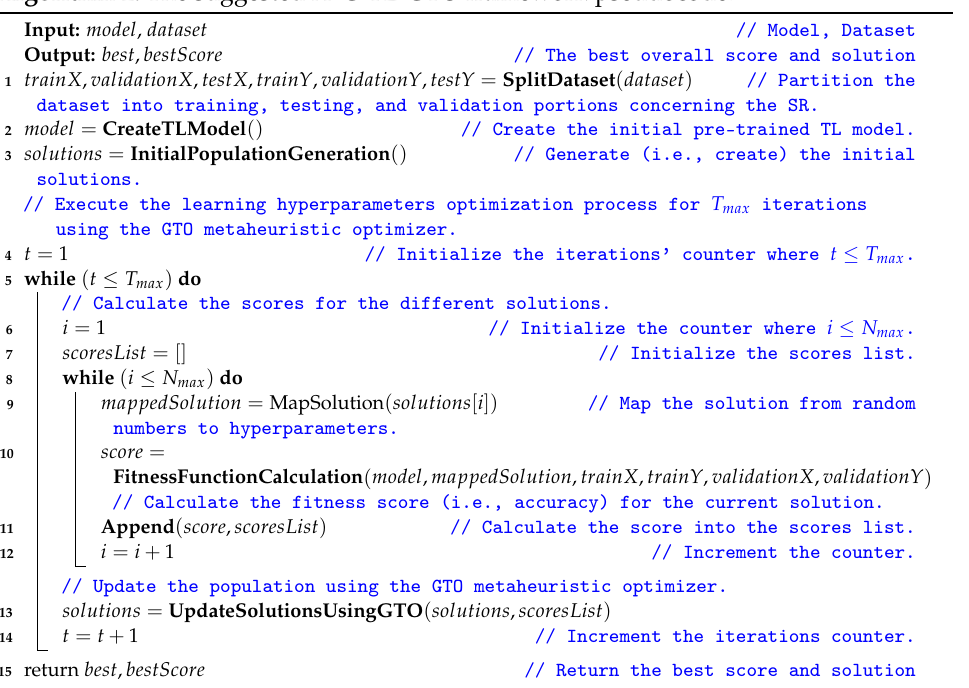
Algorithm 2: The suggested A 3 C-TL-GTO framework